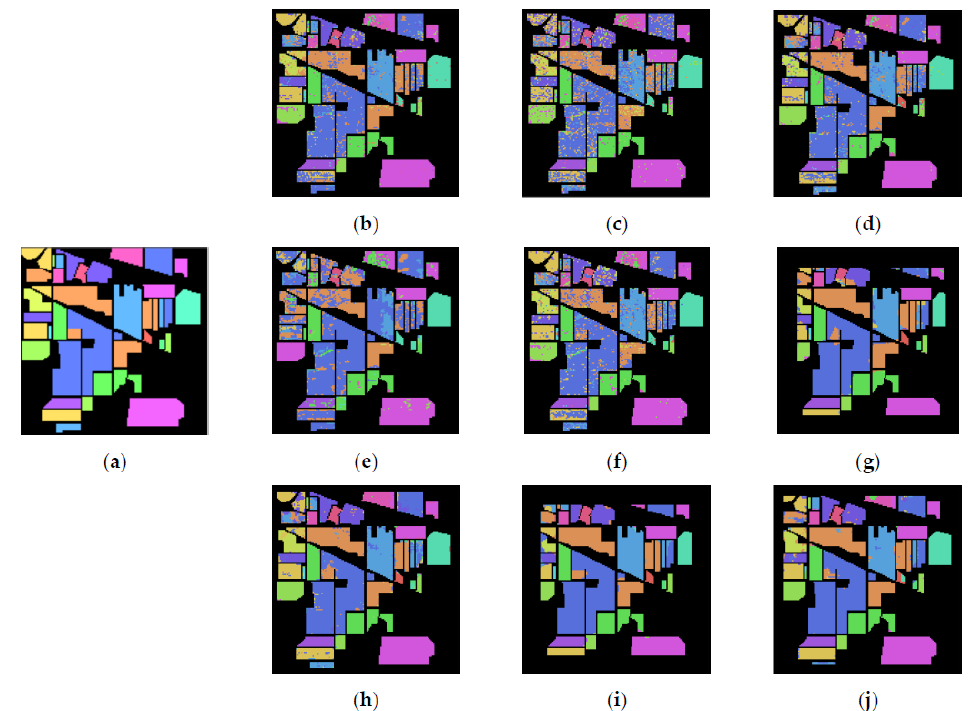
Figure 16. The ground truth and classification maps of the nine models on the Indian Pines dataset. ( a ) The ground truth. ( b ) SVM. ( c ) RNN. ( d ) ANN. ( e ) 1D CNN. ( f ) SF. ( g ) 3D CNN. ( h ) Hamida. ( i ) HybridSN. ( j ) ESFNet.